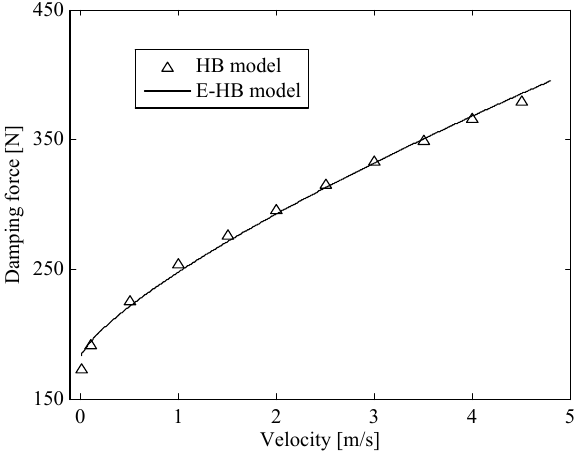
Figure 6. Damping force vs. velocity curve in the corrugated tube.